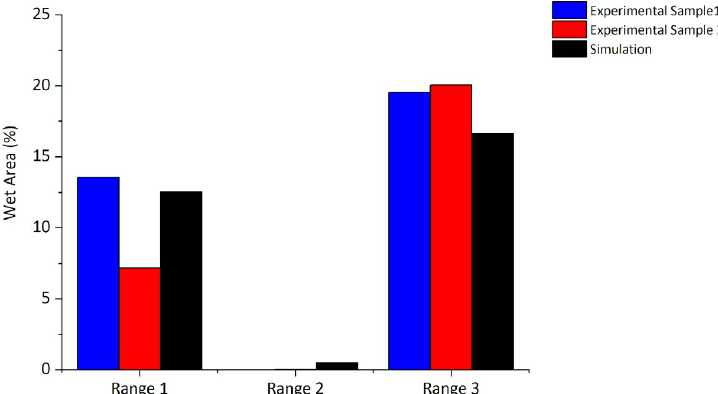
Fig 15. Percentage of wet area in the ranges analyzed inside the disinfection chamber with six nebulizer nozzles (experimental and simulation results).